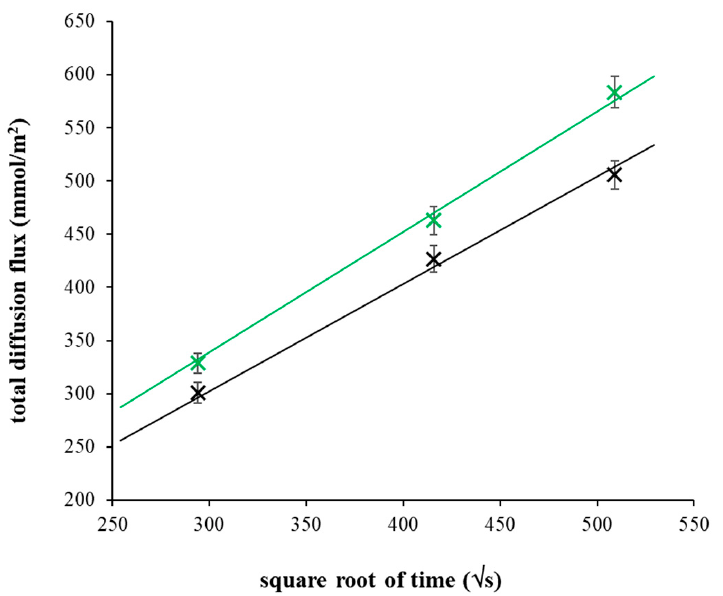
used for the fitting was determined on the basis of Equation (2) from the slope of depend ‐ ency shown in Figure 2.